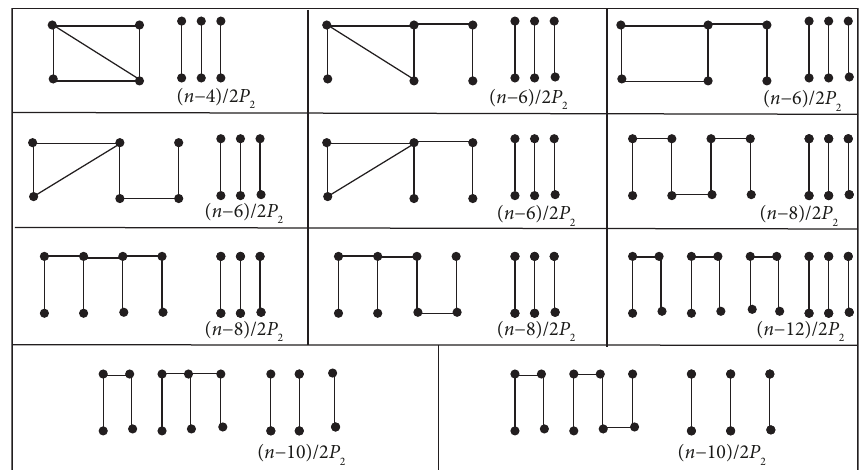
Figure 1: All possible structures of G